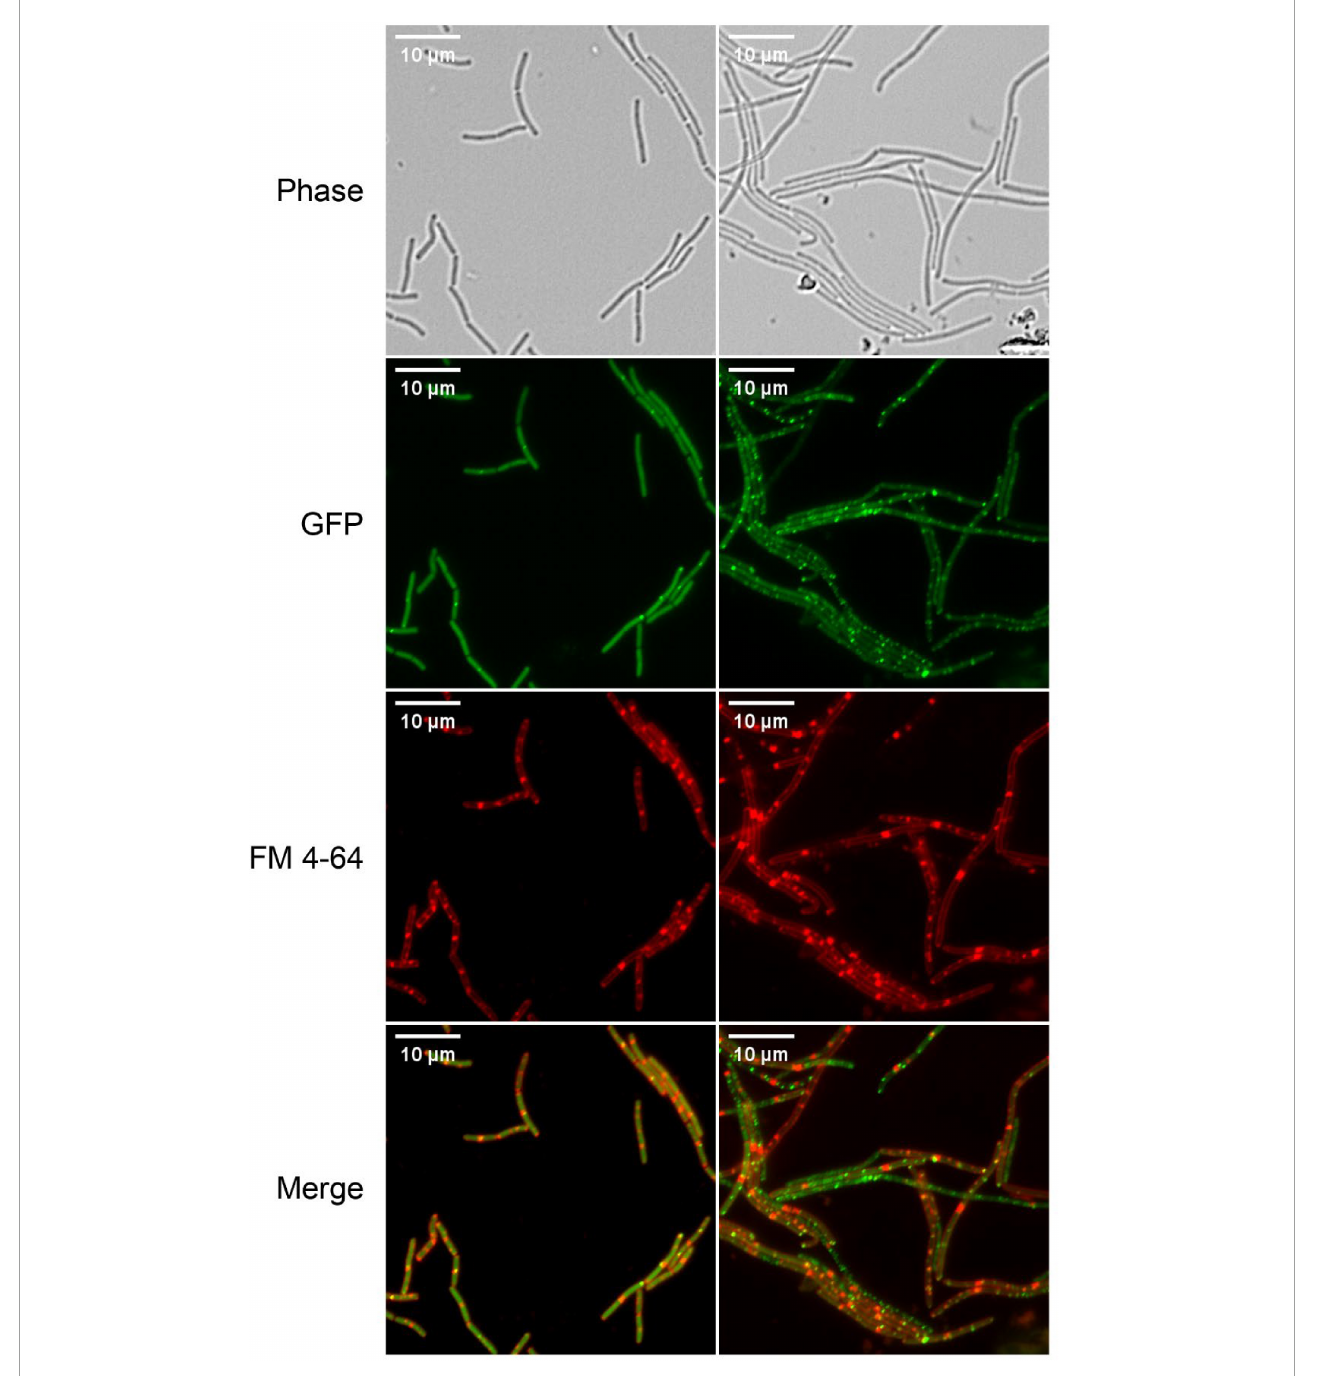
FIGURE3 Z -ring is disturbed by S2303. Overnight culture of Bacillus subtilis 168 (harboring an inducible ftsz-gfp fusion on a plasmid) diluted in LB with inducer (40 µ M IPTG) and were treated with 1% (v/v) Dimethyl sulfoxide (DMSO) or 2 µ g/mL S2303 for 4 h. The expression of the ectopic copy of FtsZ-GFP was induced with 40 µ M IPTG at 37 ◦ C. The cell membrane was stained by FM 4-64. The scale bar is 10 µ m.